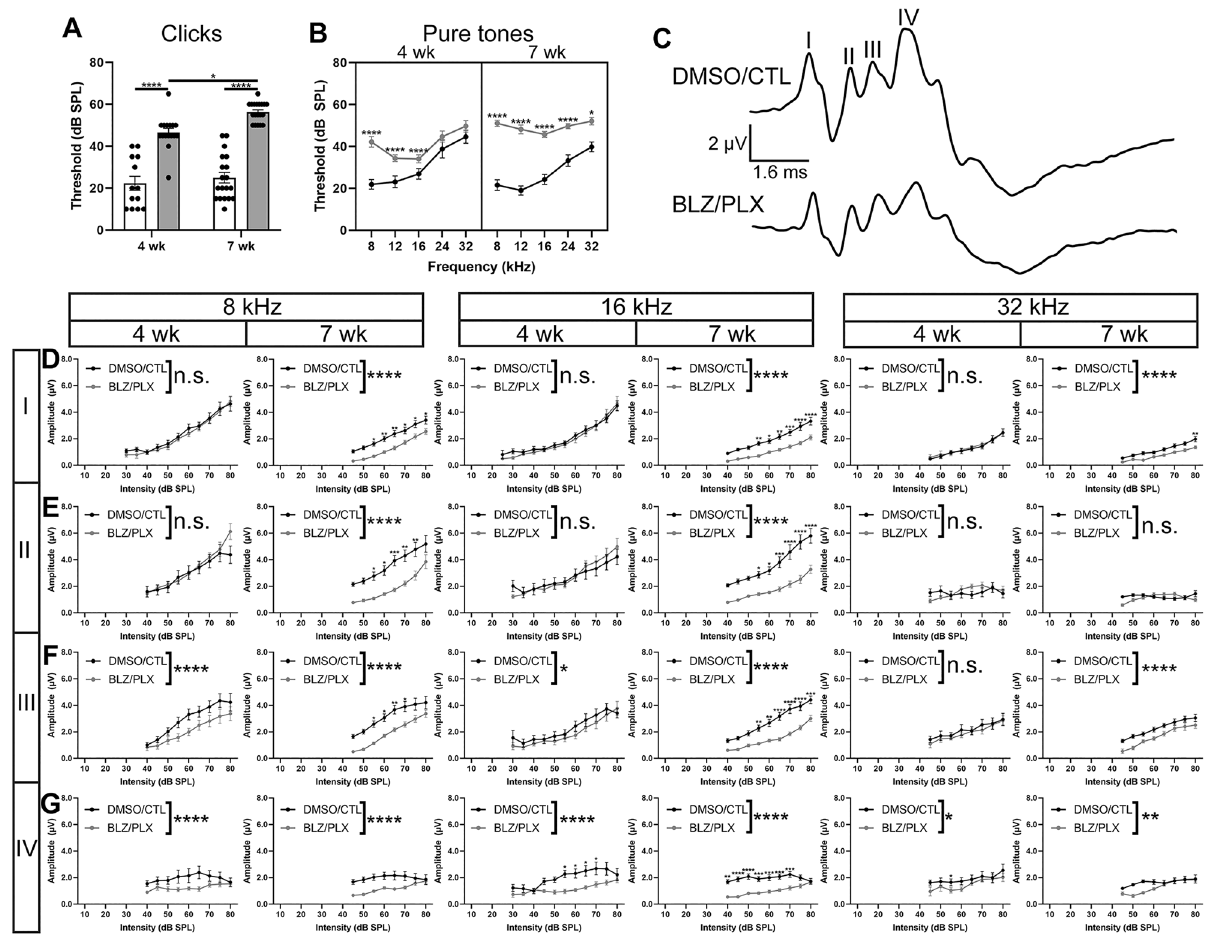
Figure 5. Auditory brainstem response reveals hearing impairments in BLZ/PLX treated mice. ( A ) Hearing thresholds (dB SPL) in response to click stimuli in 4 and 7 wk mice. BLZ/PLX treated mice had elevated hearing thresholds at both time points. ( B ) Hearing thresholds (dB SPL) in response to pure tone stimuli in 4 and 7 wk mice. BLZ/PLX mice at 4 wk had increased hearing thresholds in the lower frequencies compared to controls. At 7 wk, BLZ/PLX mice had elevated hearing thresholds at all frequency levels tested. (C) Example trace from a 7 wk control and treated mouse. ( D ) Peak I amplitudes (µV) in 4 and 7 wk mice at 8, 16, and 32 kHz, respectively. Peak amplitudes in BLZ/PLX mice were comparable to controls at 4 wk and diminished by 7 wk. ( E ) Peak II amplitudes in 4 and 7 wk mice at 8, 16, and 32 kHz, respectively. Peak amplitudes in BLZ/PLX mice were comparable to controls at 4 wk but diminished by 7 wk in the low and middle frequencies. ( F ) Peak III amplitudes in 4 and 7 wk mice at 8, 16, and 32 kHz, respectively. Peak amplitudes in BLZ/PLX mice were diminished in low and middle frequencies at both 4 and 7 wk of age. Peak III amplitude at 32 kHz in BLZ/PLX mice was comparable to controls at 4 wk but decreased by 7 wk. ( G ) Peak IV amplitudes in 4 and 7 wk mice at 8, 16, and 32 kHz, respectively. Peak amplitudes in BLZ/PLX mice were diminished at both 4 and 7 wk in each frequency tested. Asterisks indicate significant differences between age-matched control or treated groups. * p <